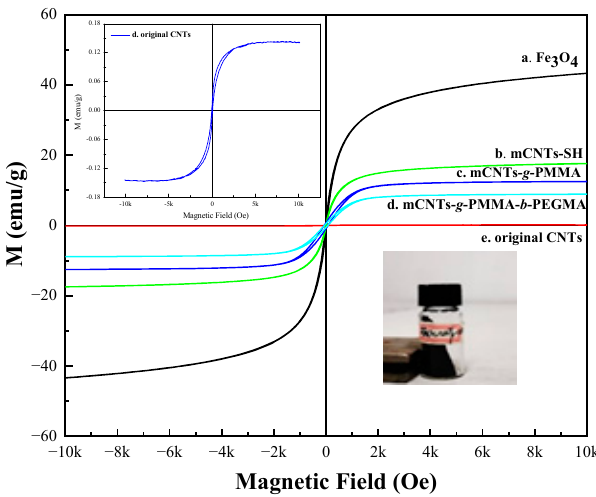
Figure 3. XRD of magnetically functionalized CNTs and Fe 3 O 4 . Figure 4 shows a hysteresis loop diagram of mCNTs, including –SH, single chains, and diblock chains grafting functionalized ones. All mCNT hysteresis curves pass through the origin, indicating that residual field strength (Br) and coercivity (HD) are equal to zero. The mCNTs and mCNTs-SH grafted with different polymer segments show The mCNTs and mCNTs-SH grafted with different polymer segments show superparamag- superparamagnetism. Among them, the mCNTs-SH obtains a saturation magnetic field netism. Among them, the mCNTs-SH obtains a saturation magnetic field induction strength induction strength of 15.6 emu/g. The saturation magnetic induction strength of single- of 15.6 emu/g. The saturation magnetic induction strength of single-chain grafting mCNTs chain grafting mCNTs and diblock grafting mCNTs is 14.3 emu/g and 12.8 emu/g, respec- and diblock grafting mCNTs is 14.3 emu/g and 12.8 emu/g, respectively. Compared with tively. Compared with mCNTs-SH, the saturation magnetic induction strength of the mCNTs-SH, the saturation magnetic induction strength of the grafted mCNTs is reduced, grafted mCNTs is reduced, which is caused by the reduction of the mass ratio of magnetic which is caused by the reduction of the mass ratio of magnetic particles for grafting the particles for grafting the polymer chain to the surface of mCNTs. polymer chain to the surface of mCNTs.